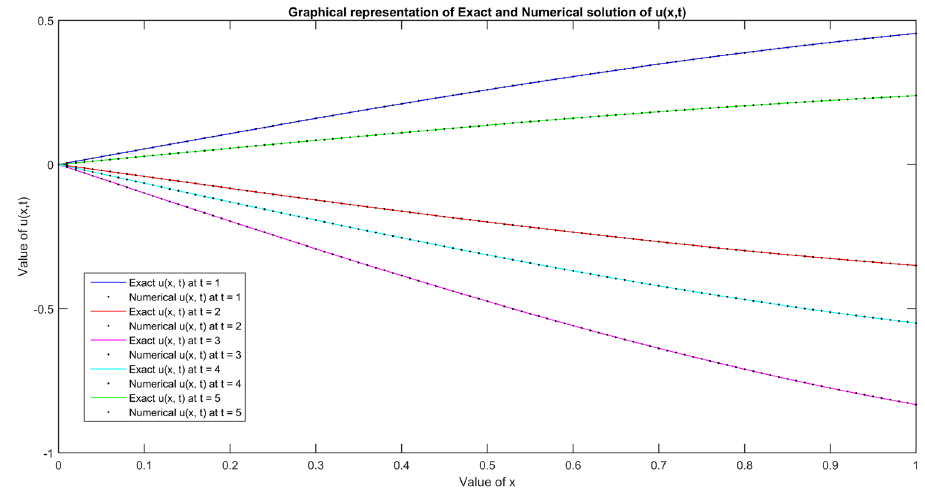
Figure 8: Comparison of ( ) u x t , at = t 1 , 2, 3, 4, and 5 for = N 101 , = α 30 , = β 5 , = t Δ 0.0001 , and = τ 0.5 using Method II regarding Example 4.